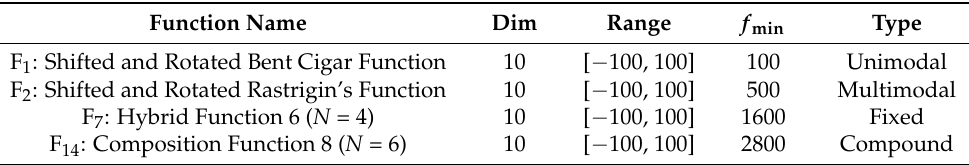
Table 2. Basic information on four different types of